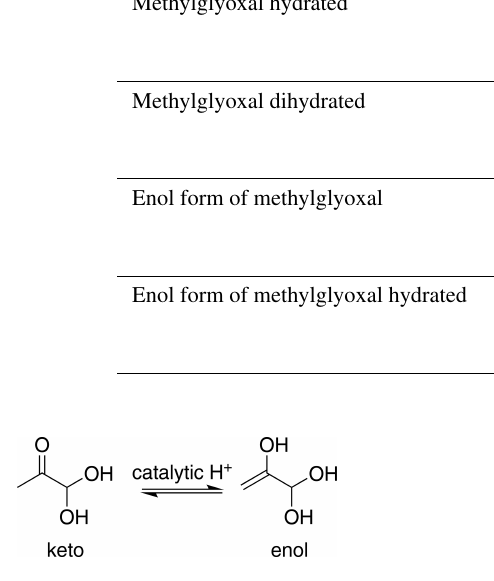
Figure 2. Enol formation from hydrated form of